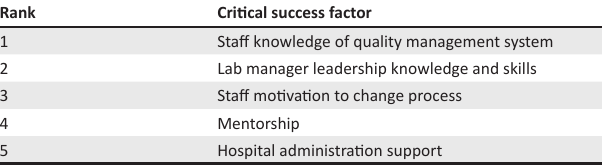
TABLE 2: Top five critical success factor categories identified during the data content analysis.